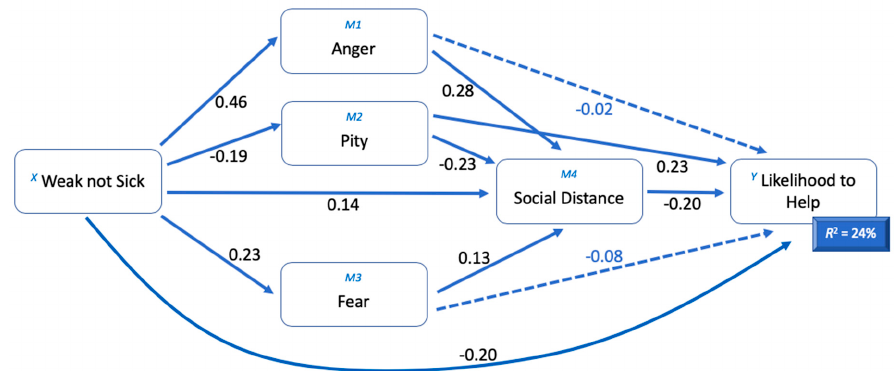
Figure 1. Anger, pity, fear and social distance as mediators in the relationship between the